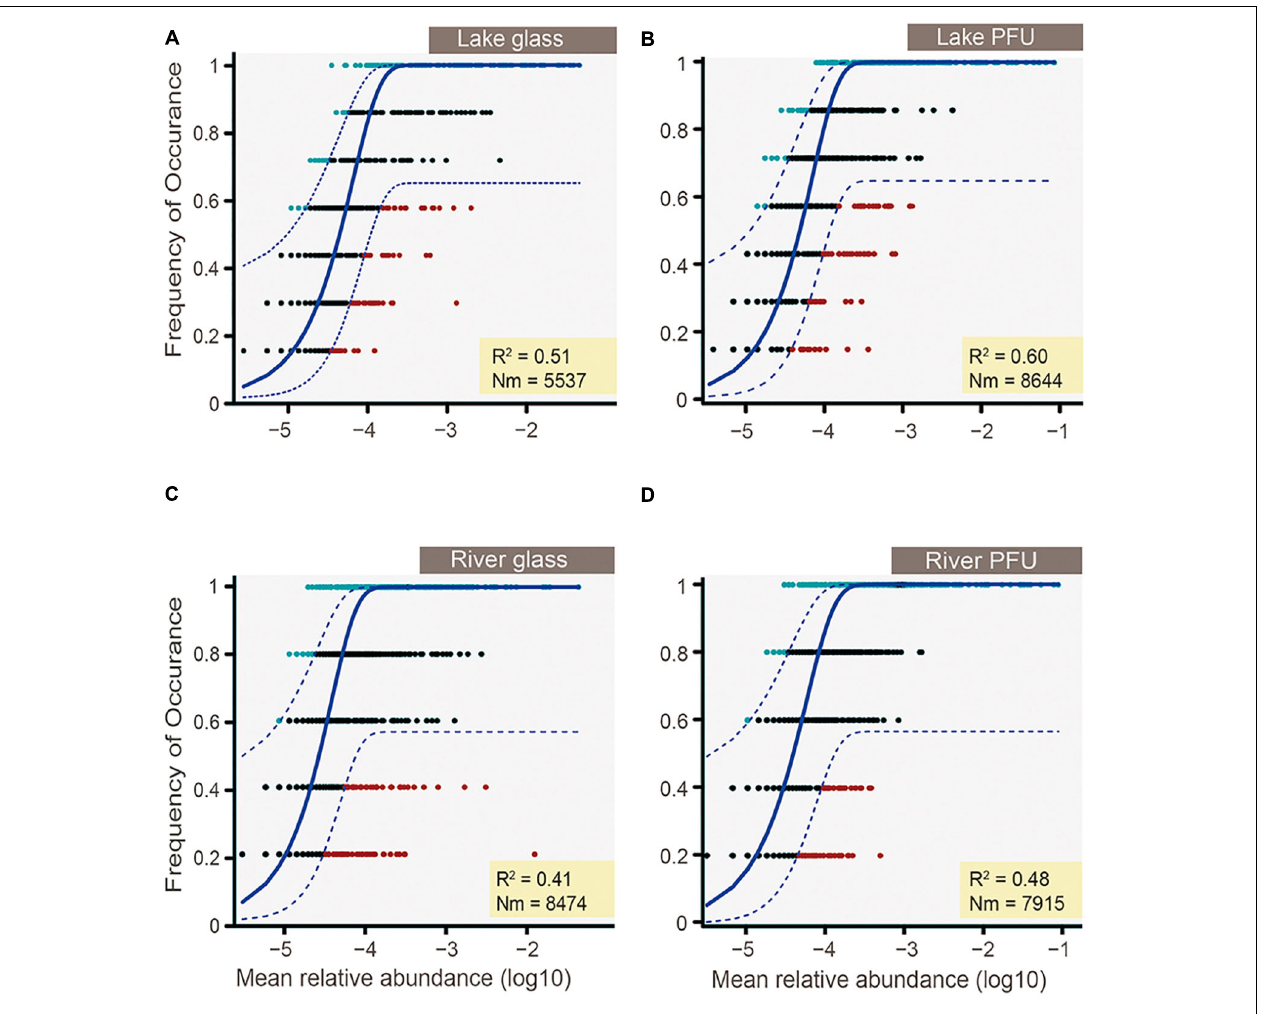
FIGURE 9 | Frequency of occurrence of OTUs as a function of mean relative abundance (logarithmic transformed) for lake glass (A) , lake PFUs (B) , river glass (C) , and river PFUs (D) . The solid blue line indicates the best fit to the neutral model as in Sloan et al. (2006), and the dashed blue line represents 95% confidence intervals around the model prediction. Different colors represent OTUs with more or less frequency than predicted. Nm indicates metacommunity size times immigration. R 2 indicates the fit to the neutral model, and negative R 2 values indicate no fit to this